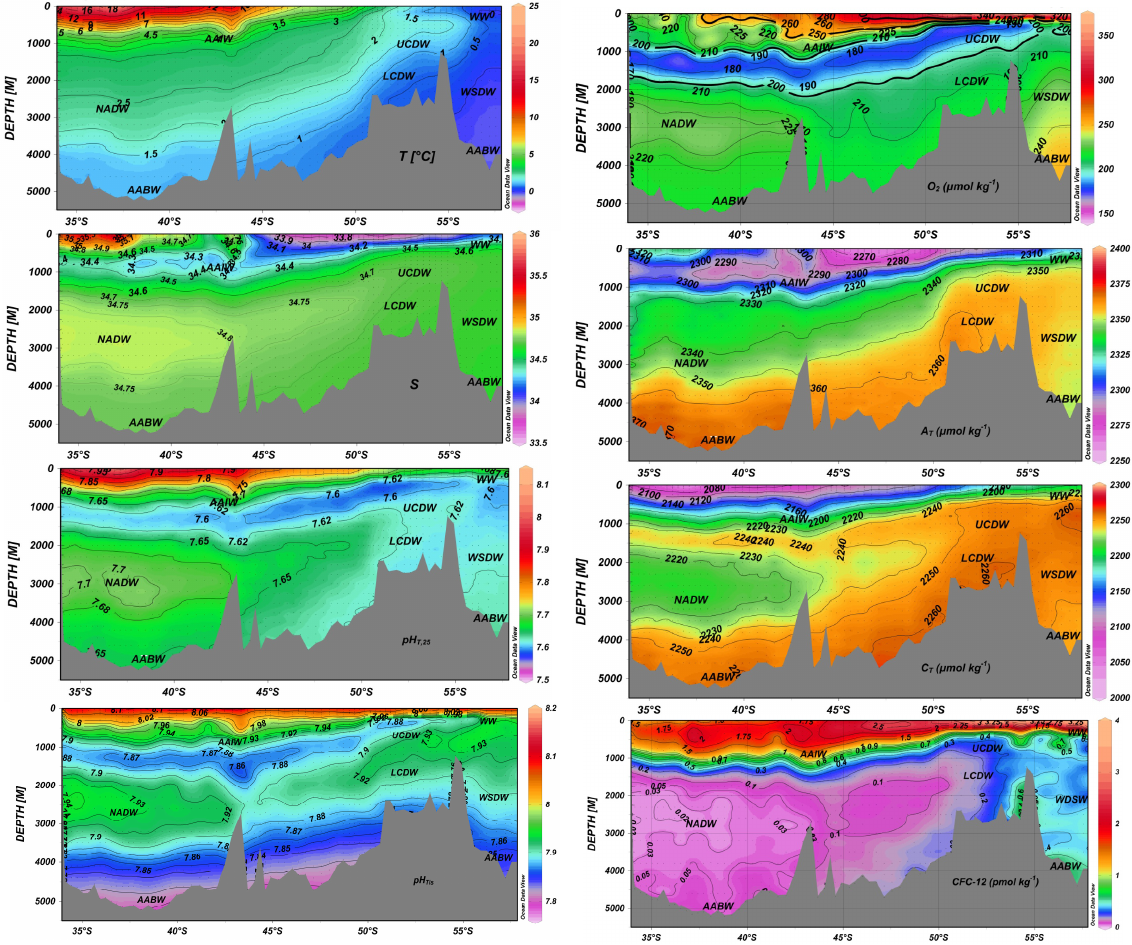
Fig. 3. The vertical distribution of temperature ( T , ◦ C), salinity ( S ), pH in total scale at 25 ◦ C (pH T , 25 ) , pH in total scale at in situ conditions (pH Tis ) , dissolved oxygen (O 2 , µmolkg − 1 ) , total alkalinity ( A T , µmolkg − 1 ) , total dissolved inorganic carbon ( C T , µmolkg − 1 ) and chlorofluorocarbon-12 (CFC-12, pmolkg − 1 ) along the southeast Atlantic sector of the Southern Ocean during February to March 2008. The dots indicate the locations of discrete